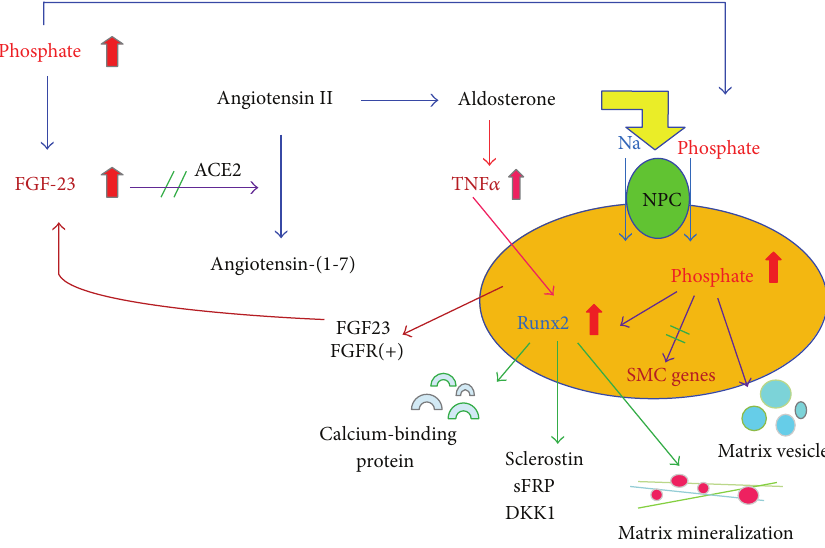
Figure 3: Factors related to the osteogenic transdifferentiation of vascular smooth muscle cells in chronic kidney disease (CKD). Hyperphosphatemia stimulates the secretion of FGF-23 from osteocytes in the bone, which inhibit the activity of angiotensin-converting enzyme 2 (ACE2). FGF23 blocks the conversion of angiotensin II into angiotensin (1-7). Therefore, angiotensin II will enhance the production of aldosterone. Phosphate and calcium stimulate the Na-Pi cotransporter, and aldosterone also contributes to activate the Na-Pi cotransporter, resulting in increased phosphate entrance into VSMCs. In addition, aldosterone accentuates the inflammatory status in part by TNF 𝛼 . Both oxidative/inflammatory status and increased intracellular phosphate levels promote VSMCs to transdifferentiate into phenotypic osteoblast cells, which causes the ossification of the vascular wall to progress. As a whole, the calcified vessels have more prominent bone formation characteristic than bone resorption ones. In addition, osteogenic cells may secrete sclerostin (SOST) and FGF23. The secreted FGF23 from the calcified vessel may contribute further increased FGF23 serum